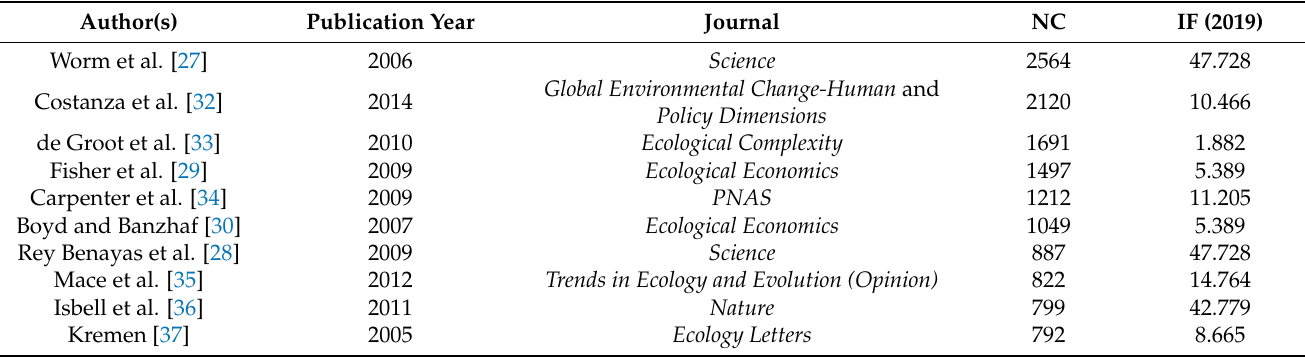
Table 1. Top 10 highly cited articles ( ≥ 200, citation) in ecosystem services research in Web of Science Core Collection (WoSCC) database from 2000 to